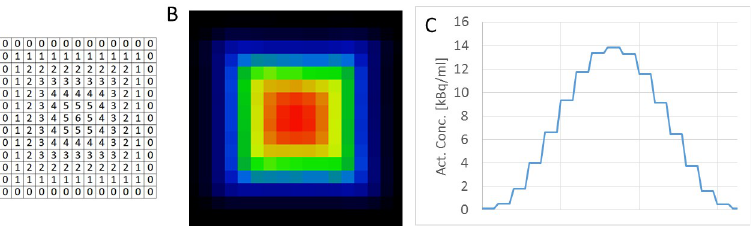
Fig 4. Activity concentration as the function of dwell time. The dwell time matrix in sec (A), the corresponding activity distribution on the reconstructed PET image (B) and the line profile through the center of the image (C).